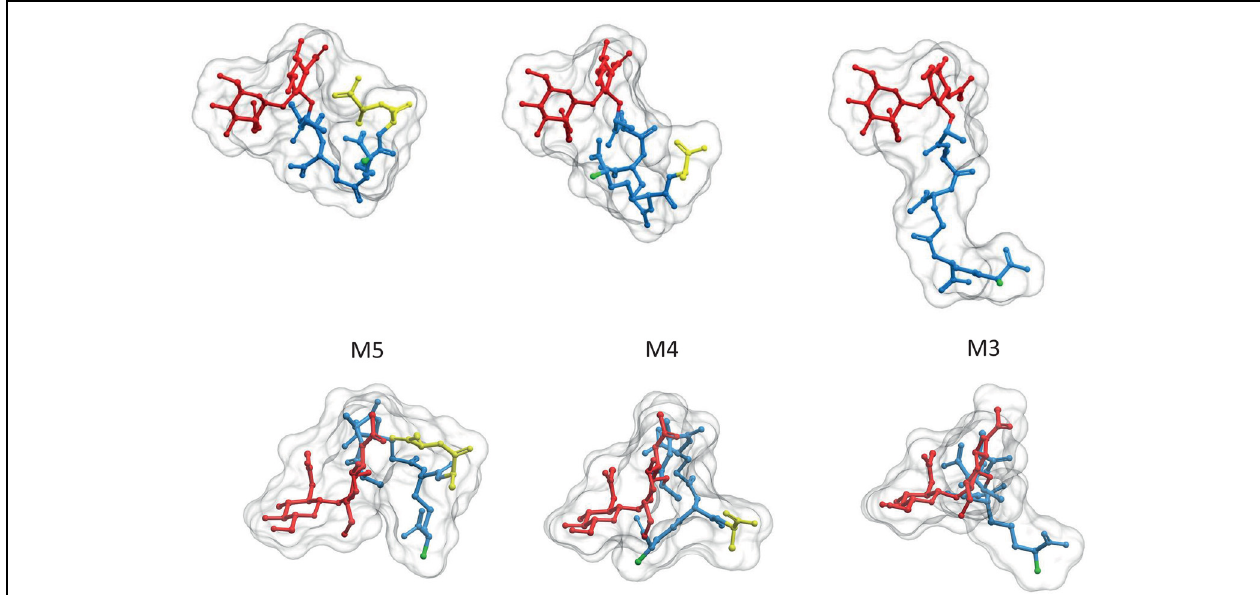
FIGURE 2 | Elimination of the terminal D -ala residue has strong influence on the 3D structure of PG subunits. PG monomeric subunits derived from the M5 by elimination of the terminal D -ala (M4) or the terminal D -ala- D -ala (M3) are compared in two orientations, transversal to (upper panel) and from above (lower panel) the surface of the sacculus. To facilitate